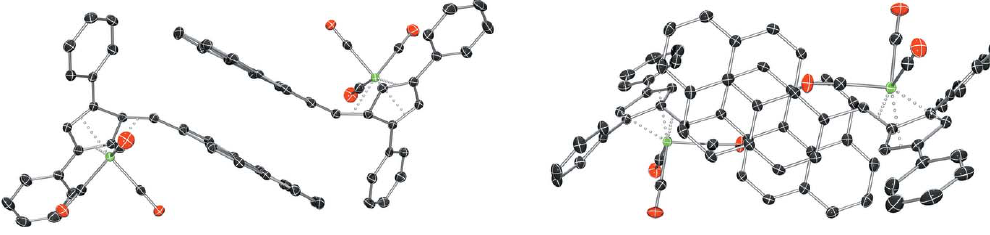
Figure 6 The (cid:2) – (cid:2) stacking arrangement of III , viewed in the plane (left) and normal to the place (right) of the pyrene rings. Displacement ellipsoids are shown at the 50% probability level. Hydrogen atoms have been omitted for clarity.